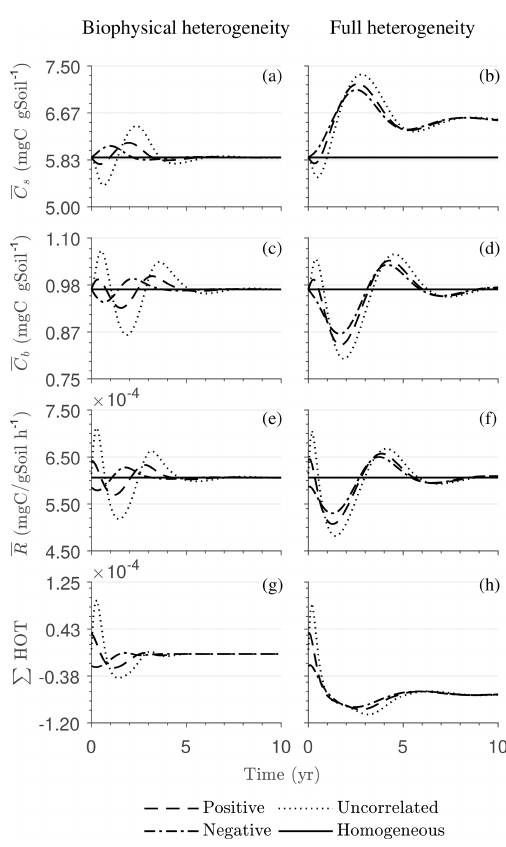
Figure 4. Scenario 1 (steady-state simulation): effect of biophysical (left) and full heterogeneity (right) on the macroscopic decomposi- tion dynamics when the substrate is distributed randomly around the steady state and only considering multiplicative kinetics at the microscale: (a, b) mean substrate C ( C s ), (c, d) mean microbial C ( C b ), (e, f) mean respiration rate ( R ), and (g, h) sum of second- and third-order terms (cid:0)(cid:80) HOT (cid:1) .